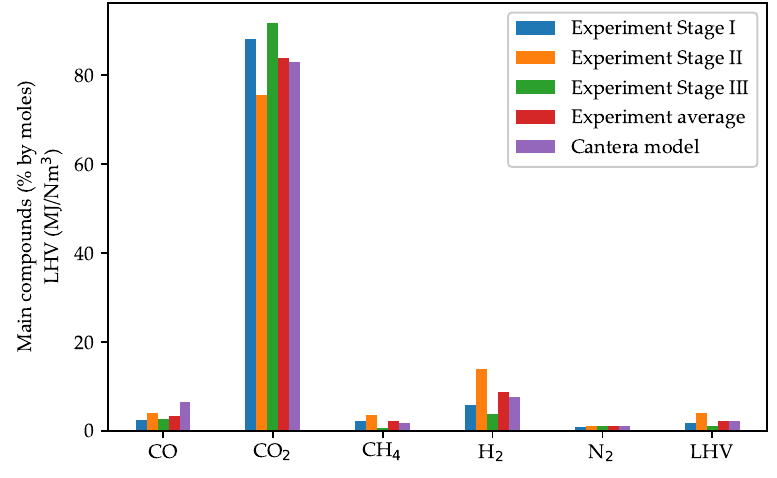
Figure 4. Comparison of average gas compositions for the three gasification stages and the average total gas composition of the Oltenia ortho-lignite experiment [52] against the results of our Cantera model (T = 580 ◦ C, p = 1 MPa, stoichiometric ratio =